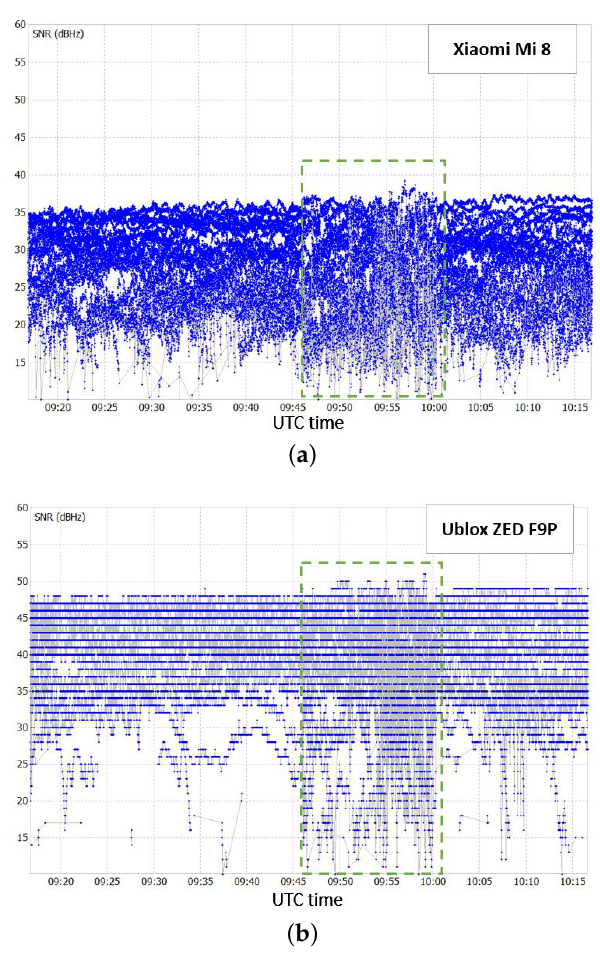
Figure 6. SNR for Xiaomi Mi 8 receiver and ( a ) for u − blox ZED F9P receiver ( b